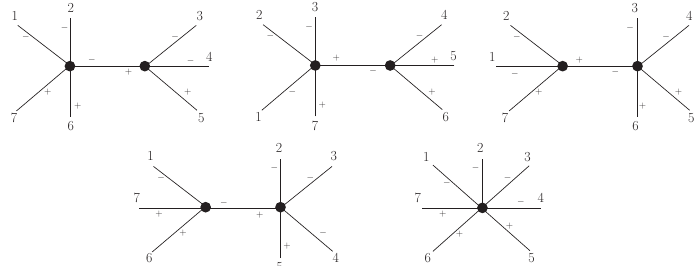
Figure 5: Contributions to the 7-point ( − − − − + + +) NNMHV amplitude. (Source of the figure: Ref. [ 8 ]